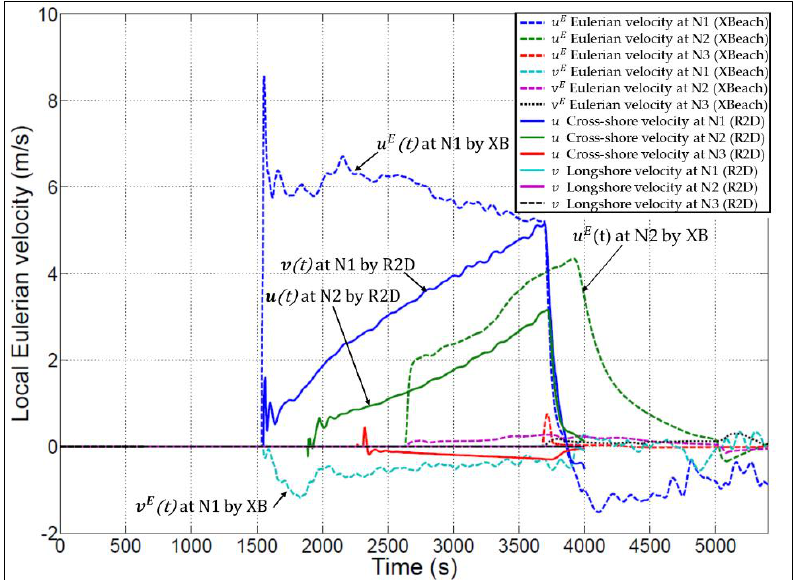
Figure 17. Comparison of flow velocities obtained from XBeach and from River-2D at the reference Figure 17 . Comparison of flow velocities obtained from XBeach and from River-2D at the points N1, N2 and N3 for load case reference points N1, N2 and N3 for load case LC1.